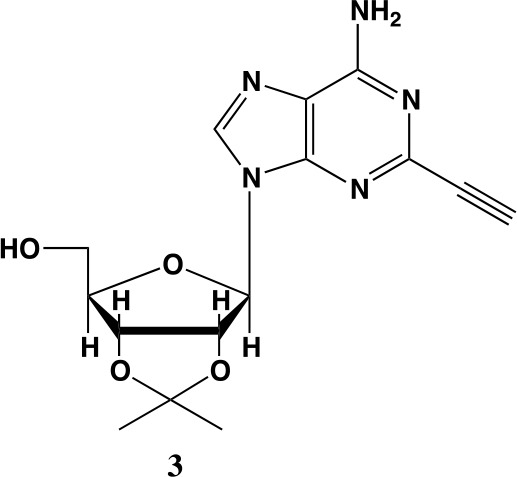
2-ethynyl-adenosine-acetonide (3).In a clean, dry round bottom flask, 20 ml of saturated 7N ammonia in methanol was added to 2 (200 mg, 0.5 mmol) and stirred for 1.5 hr until complete trimethylsilyl deprotection was observed by TLC. The reaction was concentrated in vacuo. The crude residue was purified via combi flash (MP A: hexanes, MP B: ethyl acetate; 0–1 min: 0–100% B, 1–18 min: 100% B). Fractions containing desired compound were pooled and concentrated to yield 122 mg of off-white powder (74% yield). 1H NMR (400 MHz, DMSO-d6) δ 8.43 (s, 1H), 7.55 (s, 2H), 6.10 (d, J = 2.9 Hz, 1H), 5.30 (dd, J = 6.1, 3.1 Hz, 1H), 5.16 (t, J = 5.5 Hz, 1H), 4.96 (dd, J = 6.2, 2.5 Hz, 1H), 4.23 (d, J = 3.0 Hz, 1H), 3.55 (q, J = 5.0 Hz, 2H), 1.56 (s, 3H), 1.34 (s, 3H).